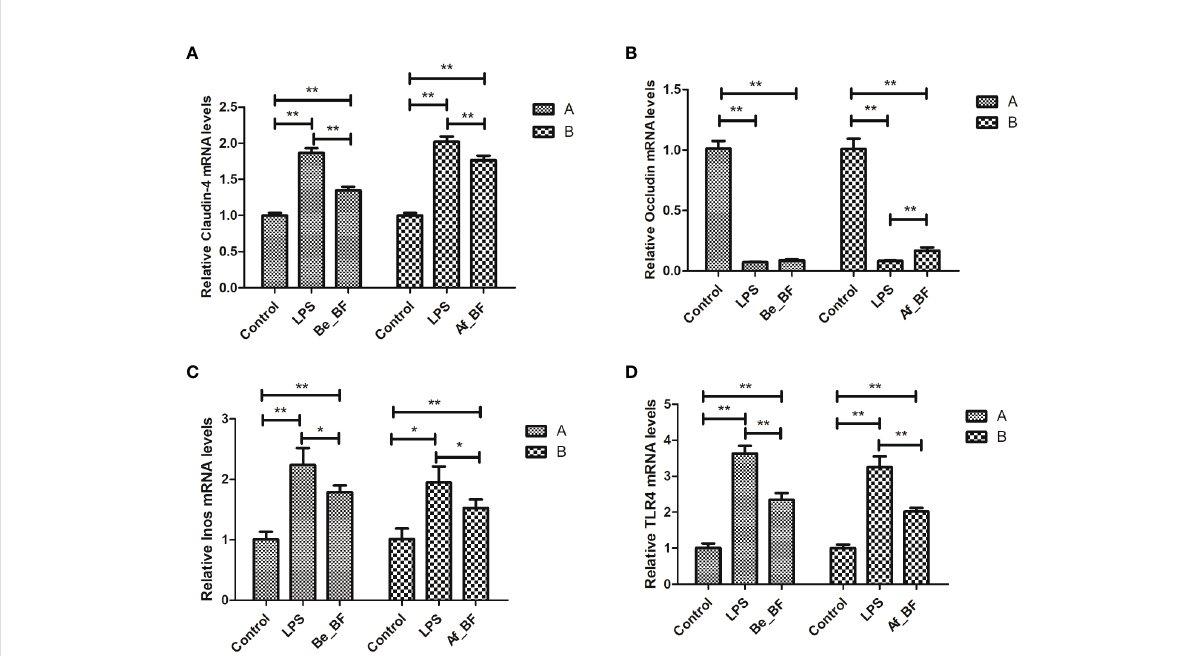
FIGURE 7 Relative expression of the release of in fl ammatory factors ( A , claudin-4; B , Occludin; C , Inos; D , TLR4) at mRNA level in the small intestine after B . fragilis treatment. LPS, LPS-treated group; Be_BF, B . fragilis treatment before injection of LPS; Af_BF, B . fragilis treatment after injection of LPS; TLR4, Toll-like receptor 4. GAPDH was used as a reference gene; * p < 0.05; ** p < 0.001.